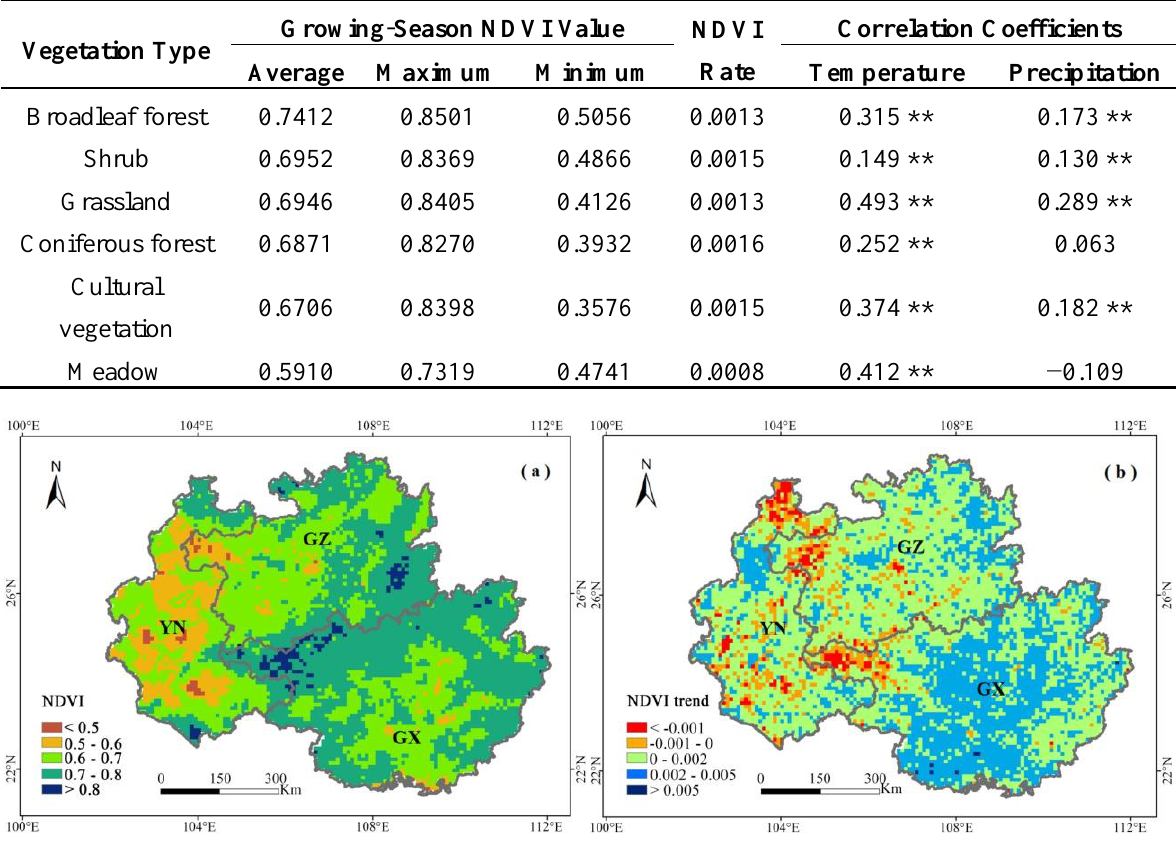
Figure 4. Spatial patterns of average values ( a ) and temporal trend ( b ) in growing-season NDVI during